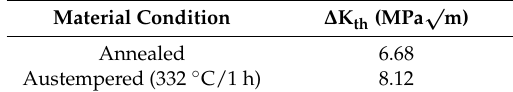
Table 5. Experimentally-Determined Values of ∆ K th for the Uncharged 4140 Steel